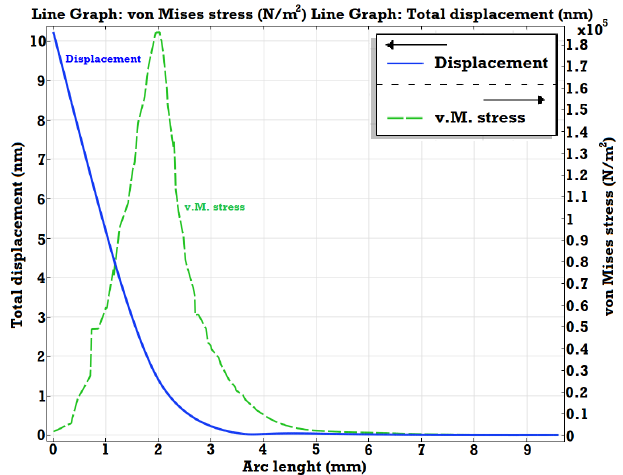
FIGURE 19. Stress and Displacement at First Mechanical Eigenfrequency